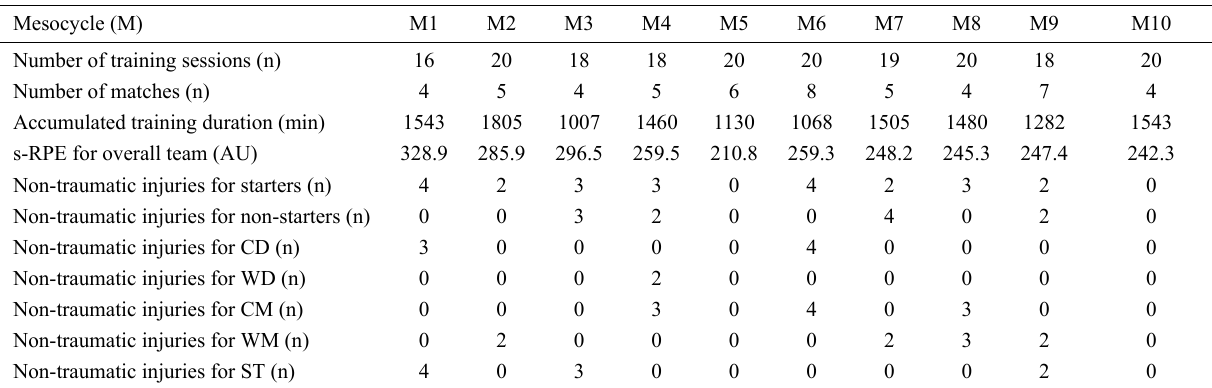
Table 1. Characteristics of mesocycles considering training sessions, competitive matches, s-RPE and injuries during the 10